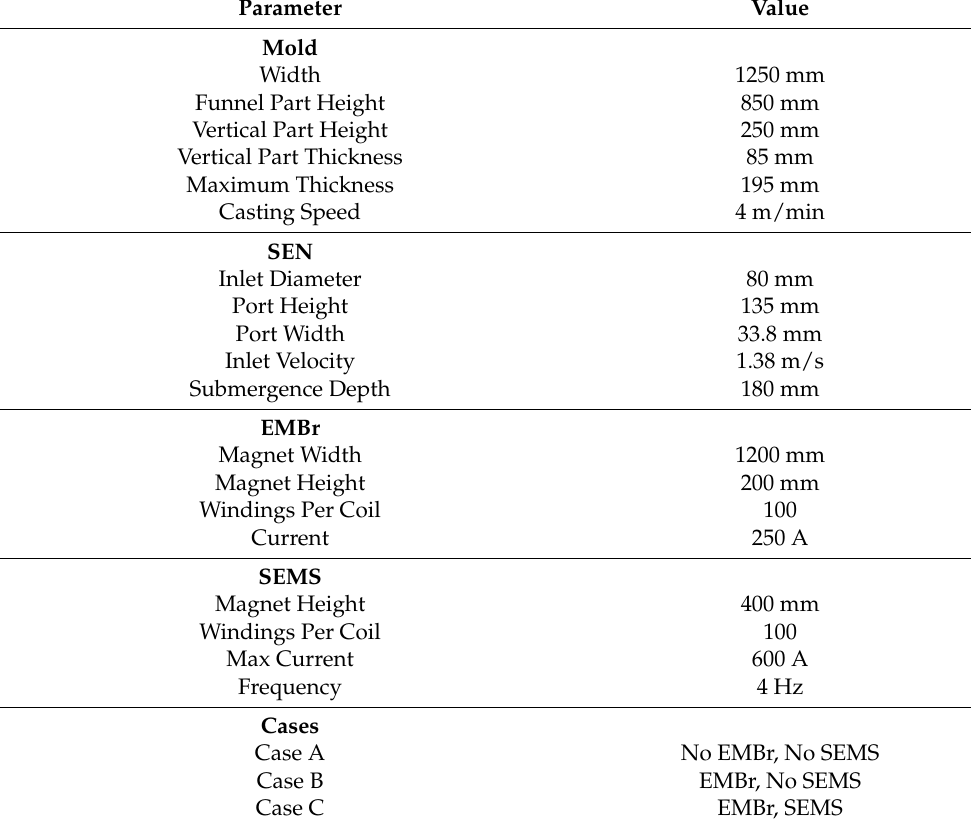
Table 1. Process